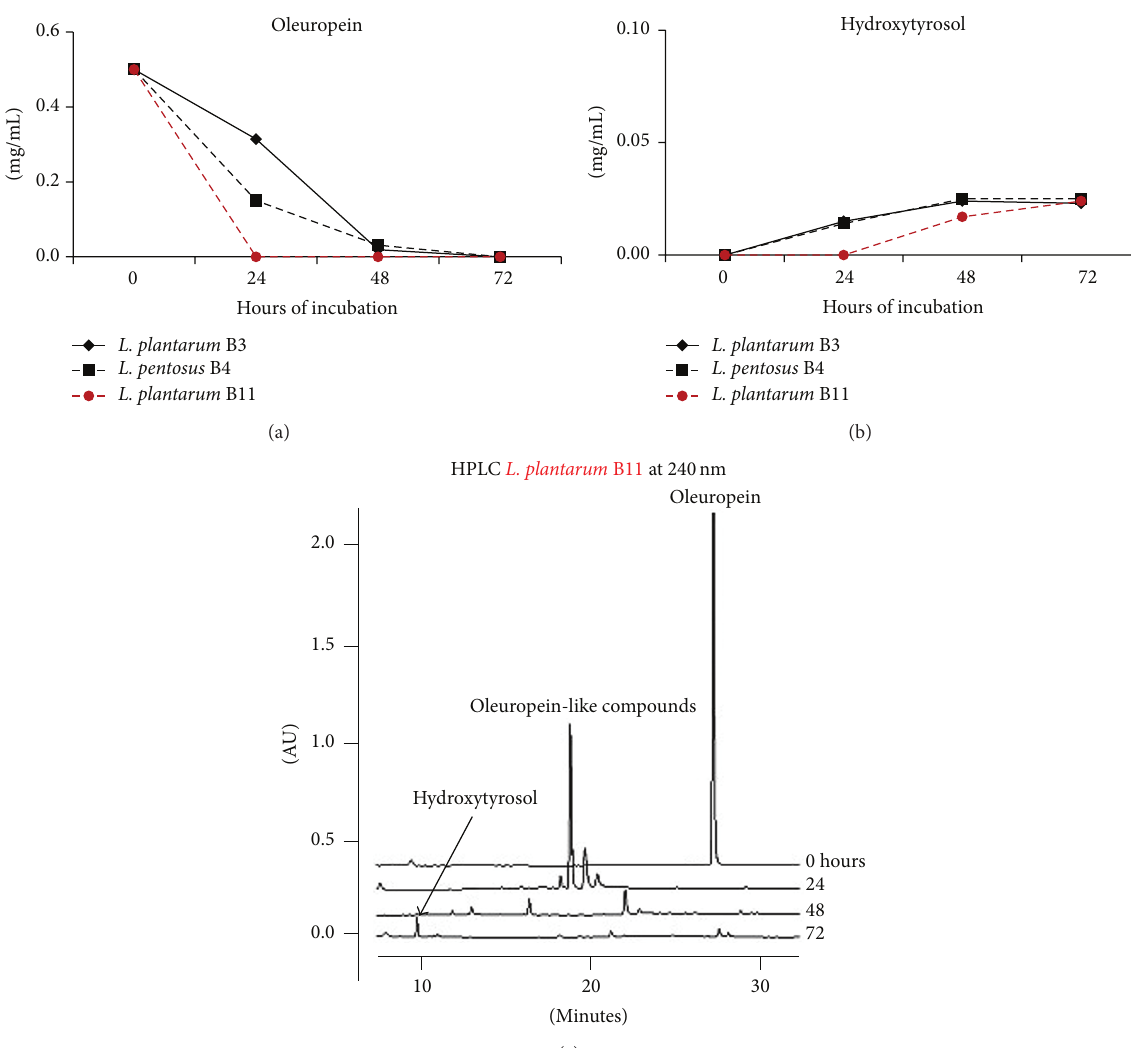
Figure 4: Changes of oleuropein (a) and hydroxytyrosol (b) followed up to 72 hours in NWB-pH 5, inoculated with the L. plantarum (B3, B11) and L. pentosus (B4) strains and incubated at 30 ∘ C. In addition, HPLC chromatograms relative to B11 strain are shown (c). Data represents the mean of three independent